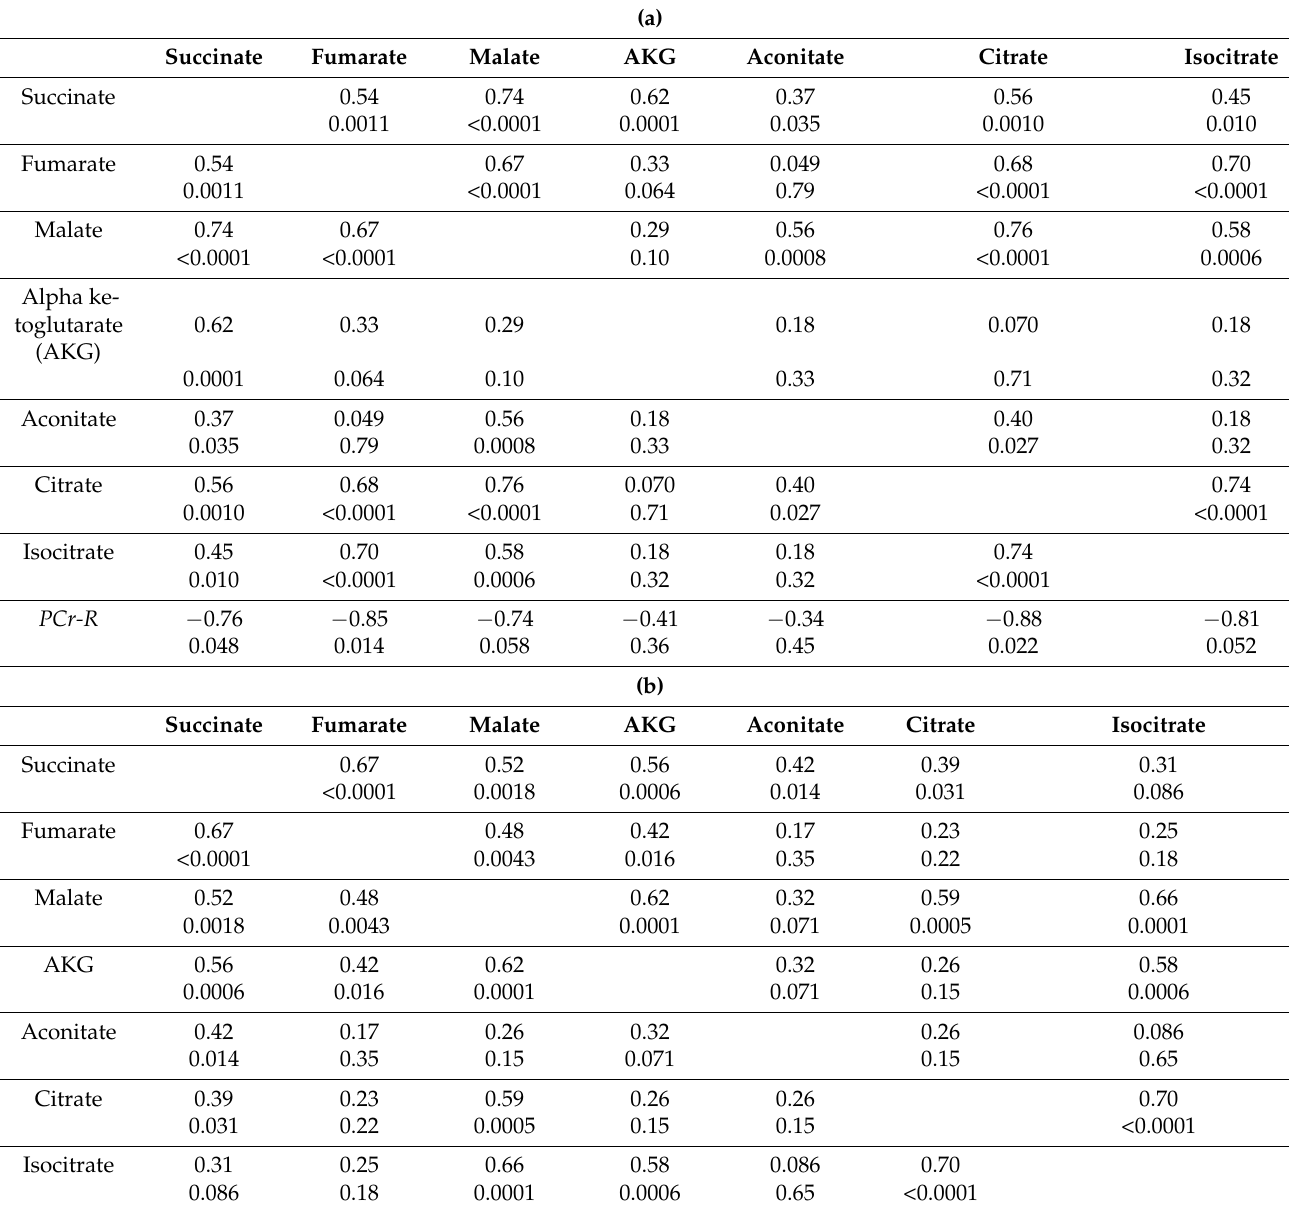
Table 3. (a) Controls: Correlations among CAC markers. (b) Cases: Correlations among CAC markers.